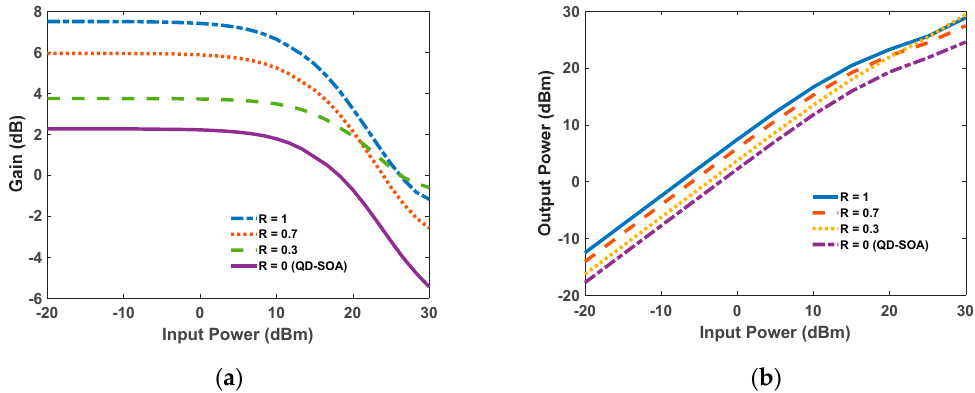
Figure 11. Gain versus input power for 4 distinct pump powers.